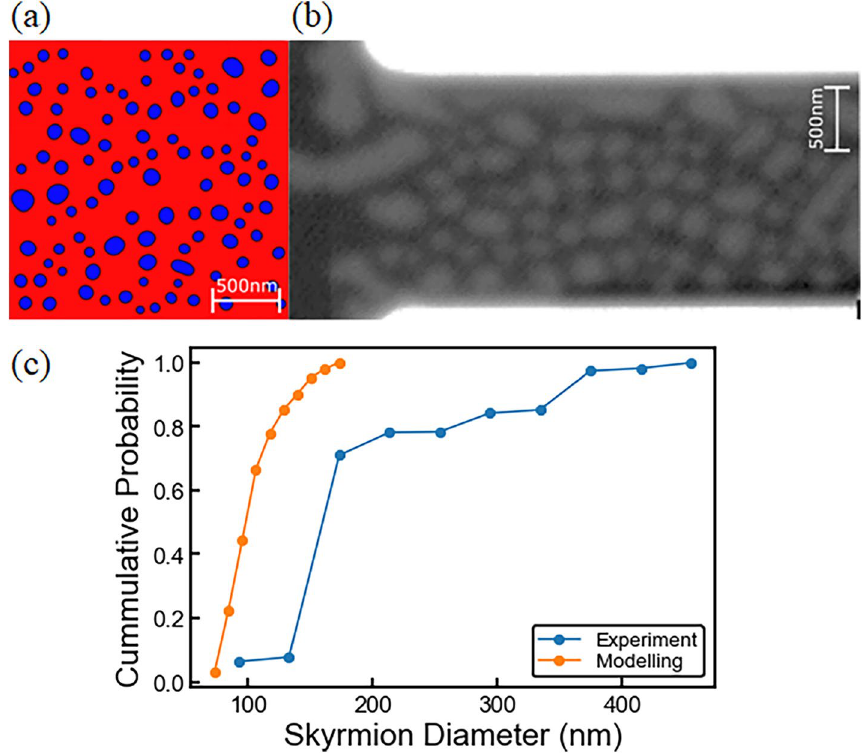
Figure 2. Skyrmion collections. ( a ) A simulated system with skyrmion density N = 12.5 Sk/µm 2 , with a range of diameters stabilised by an out-of-plane field of H = 1.2 kA/m. Blue indicates in-plane magnetization and red out-of-plane. ( b ) STXM image of a skyrmion collection after a current pulse, J C = 4.5 × 10 11 A/m 2 , in a 2 μm wide wire. Bright contrast indicates skyrmions. Images are shown at zero field. ( c ) Cumulative probability as a function of diameter, where around 75% of skyrmions in experiments are in the diameter range 70–180